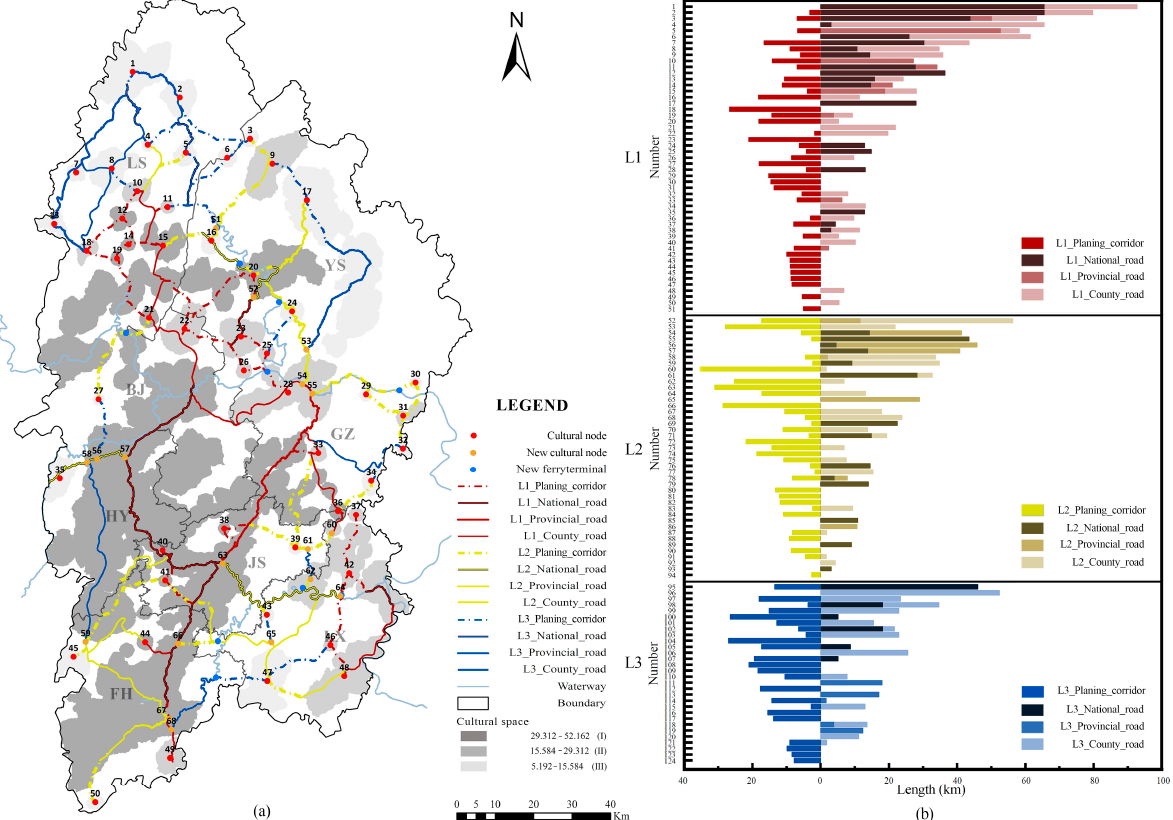
Figure 5. The spatial distribution of the cultural heritage tourism corridor network ( a ) and the type and length distribution of the corridors ( b ).